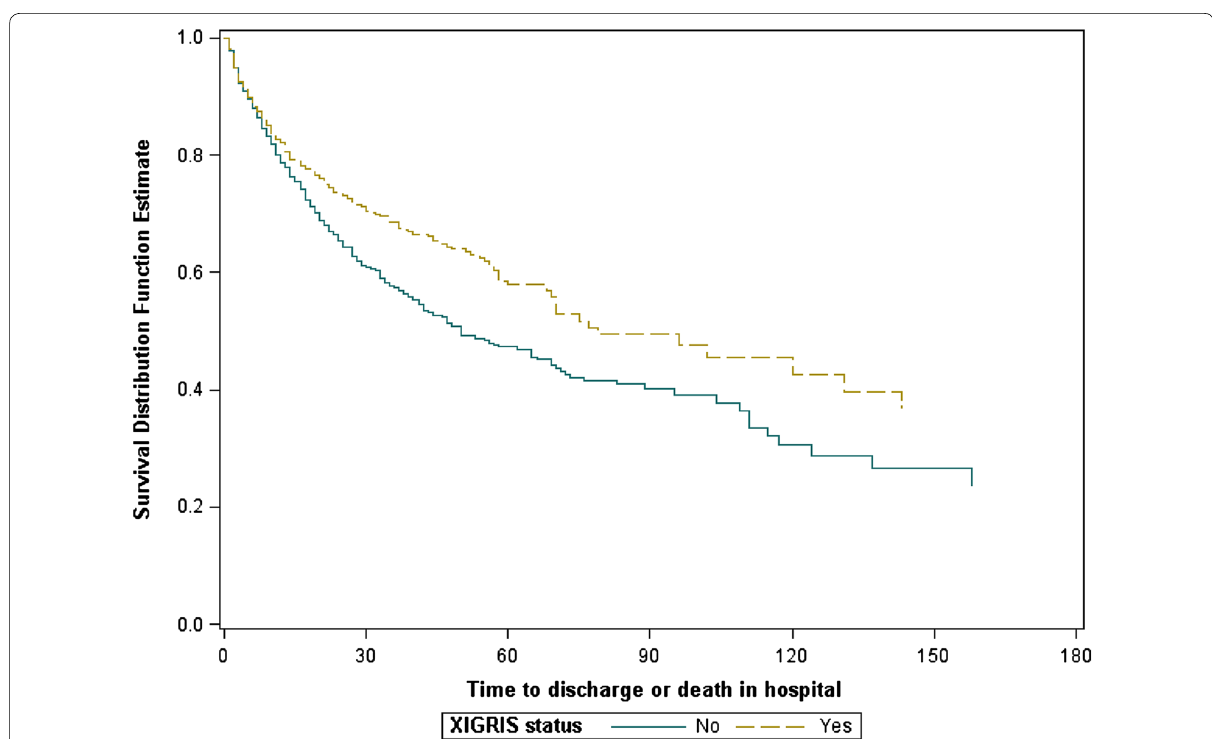
Fig. 2 Kaplan–Meier curves showing estimated 28‑day mortality rates of approximately 28% for the DrotAA (Xigris) group and 38% for the nonDro‑ tAA